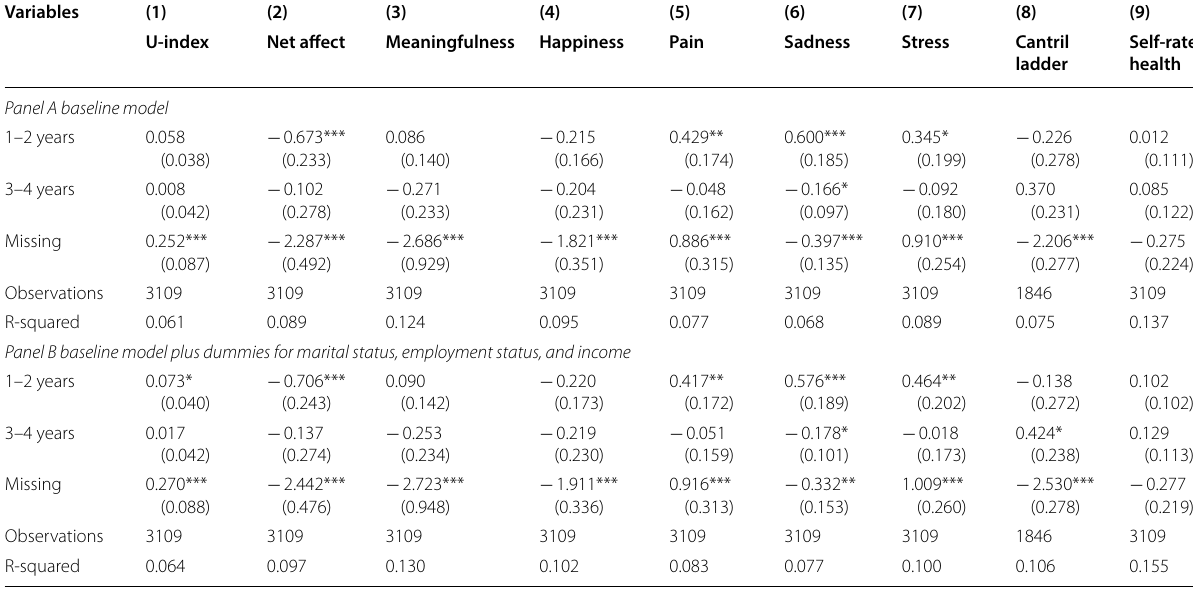
The estimates in columns 1 through 7 and 9 are OLS coefficients from the 2010, 2012, and 2013 ATUS WB Modules; the estimates in column 8 are OLS coefficients from the 2012 and 2013 ATUS WB Modules. All estimates use the WB Module final weight (WUFINLWGT). Standard errors in parentheses. *** p < 0.01, ** p < 0.05, * p < 0.1. The following control variables are included in all columns in both Panels A and B: age and its square; three dummies for race/ethnicity; five education dummies; number of disabilities; an immigrant dummy; number of children; a metropolitan status dummy; two season dummies; year dummies; dummies for the DWS year; and state dummies. Columns 1 through 7 additionally contain a holiday dummy and six dummies for the days of the week. Panel B additionally includes two marital-status dummies; two employment-status dummies; and four dummies for family income during the last 12